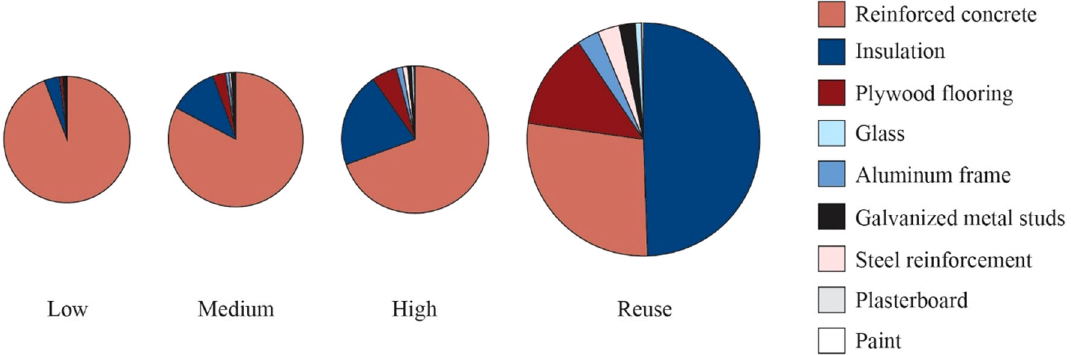
Fig. 2 Breakdown of material use global warming potential by relative social vulnerability, with material impacts assuming an intermodal steel building unit is reused and occupied its full lifespan (large pie diagram shown for